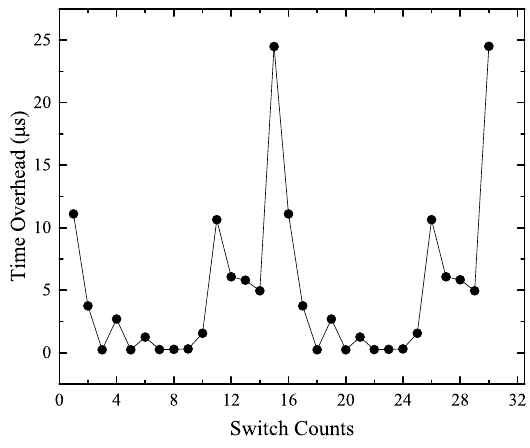
Figure 5. Context switch time overhead of